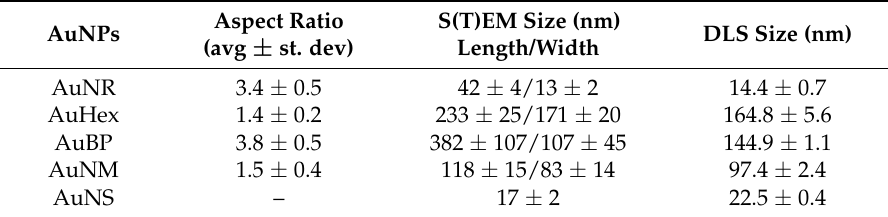
Table 1. Differences in the sizes obtained from S(T)EM and DLS measurements.